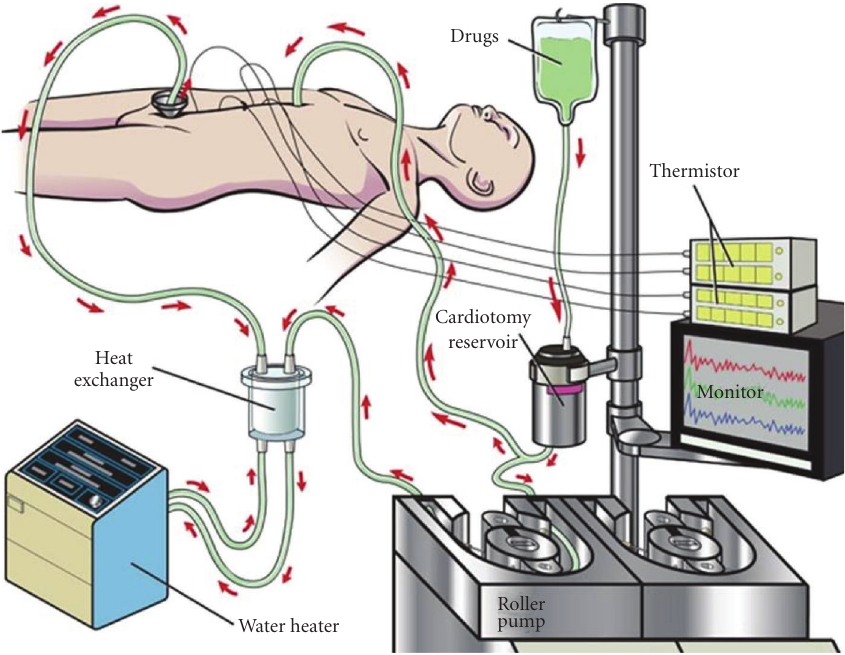
Figure 3: Continuous hyperthermic peritoneal perfusion (CHPP) . The CHPP procedure involves placing temperature probes, inflow and outflow cannulas, and continuous perfusion of plasmalyte followed by cisplatin containing chemotherapy as the perfusate at 41-42 ◦ C. To achieve this, the inflow was usually about 45 ◦ C. Manual agitation of the closed abdomen was done for 1.5 hours to ensure that all peritoneal surfaces were exposed to the cisplatin.